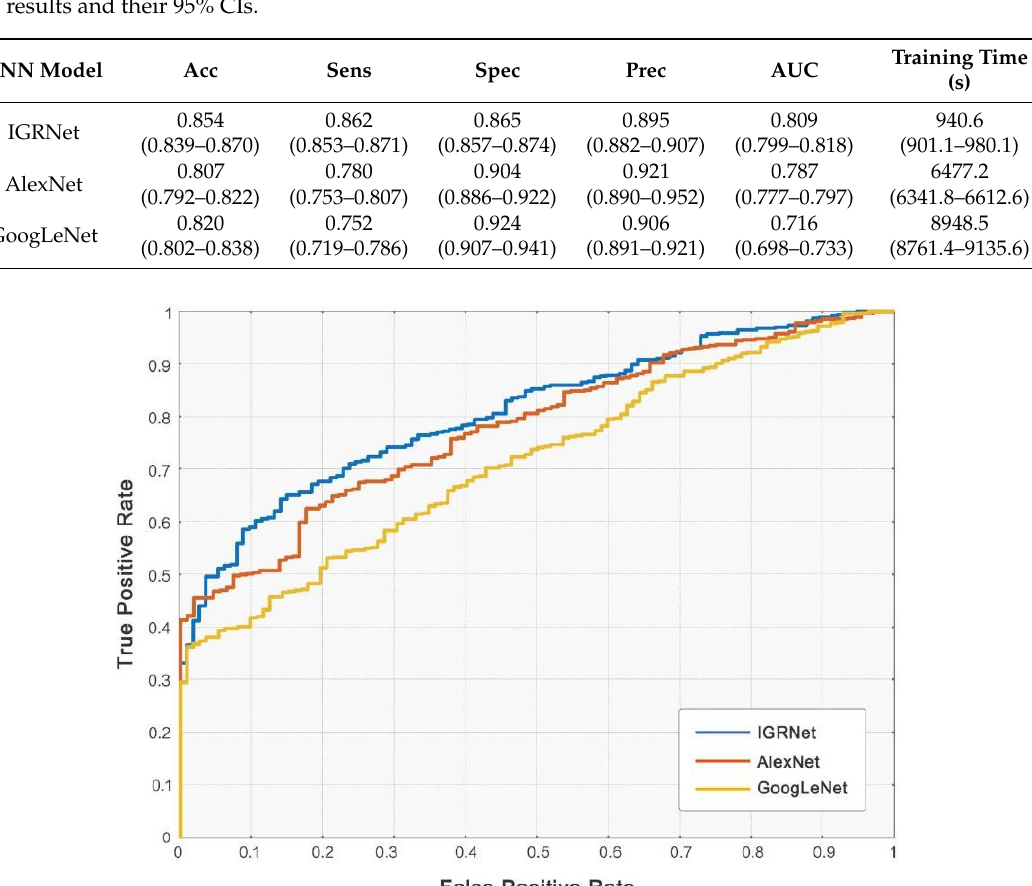
Figure 7. ROC curves of convolutional neural networks (CNNs).